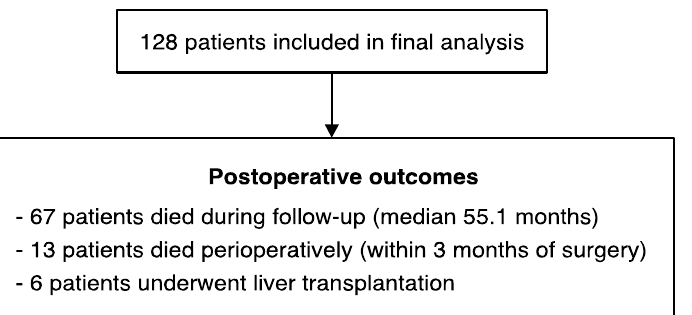
Figure A1: Schematic detailing the postoperative outcomes of the 128 patients in- cluded in the study; Table A1: Overall survival analysed by multiple Cox regression (plt count: binary variable); Table A2: Overall survival analysed by multiple Cox regression (plt count: continuous variable).